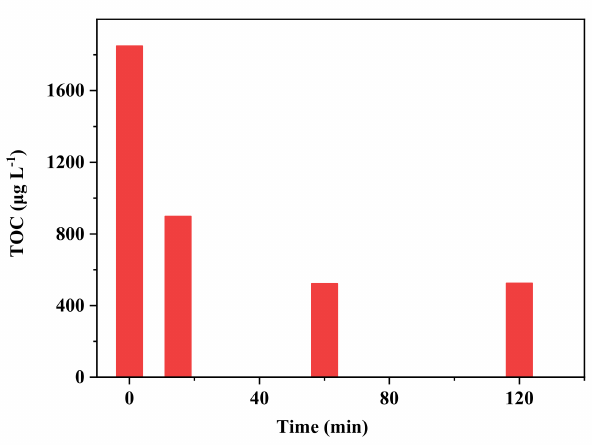
Figure 6. The removal of TOC by FeS/sulfite system. Conditions: [IOP] 0 = 1.5 mg L − 1